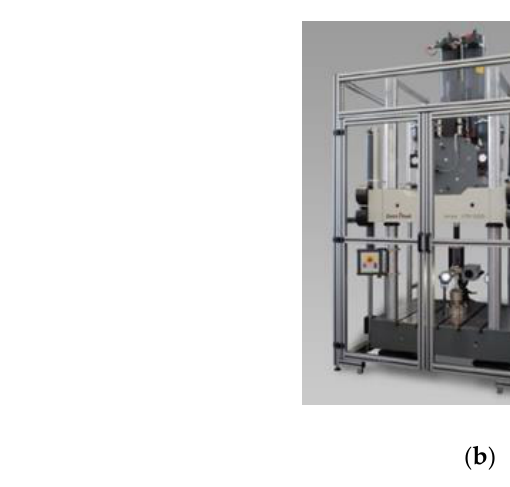
Figure 1. Specimen geometry in mm: ( a ) quasi-static test specimen; ( b ) dynamic test specimen.